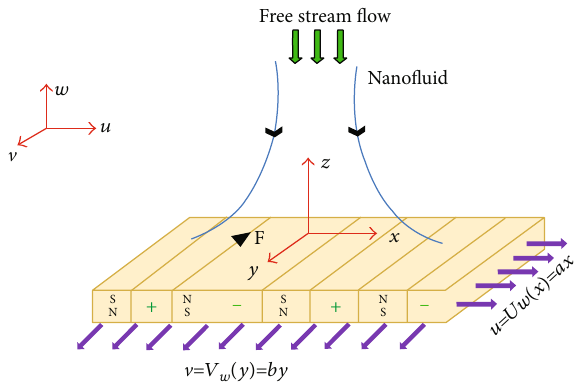
Figure 1: Geometry of fl ow